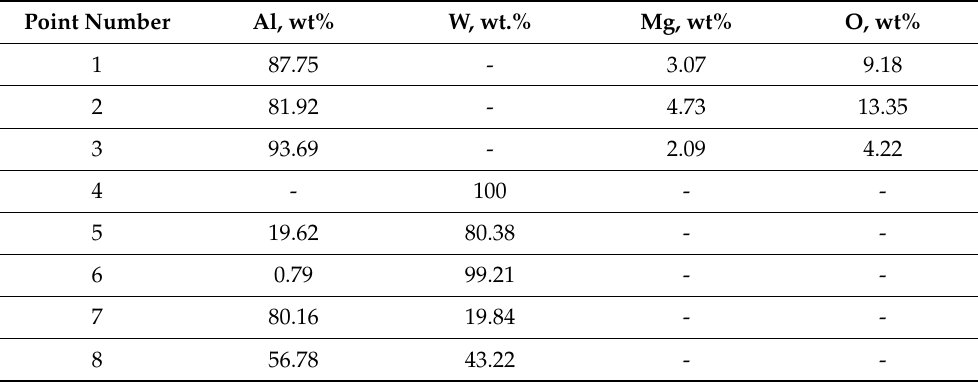
Table 1. Results of EDS analysis of Al-5Mg alloys (see Figure